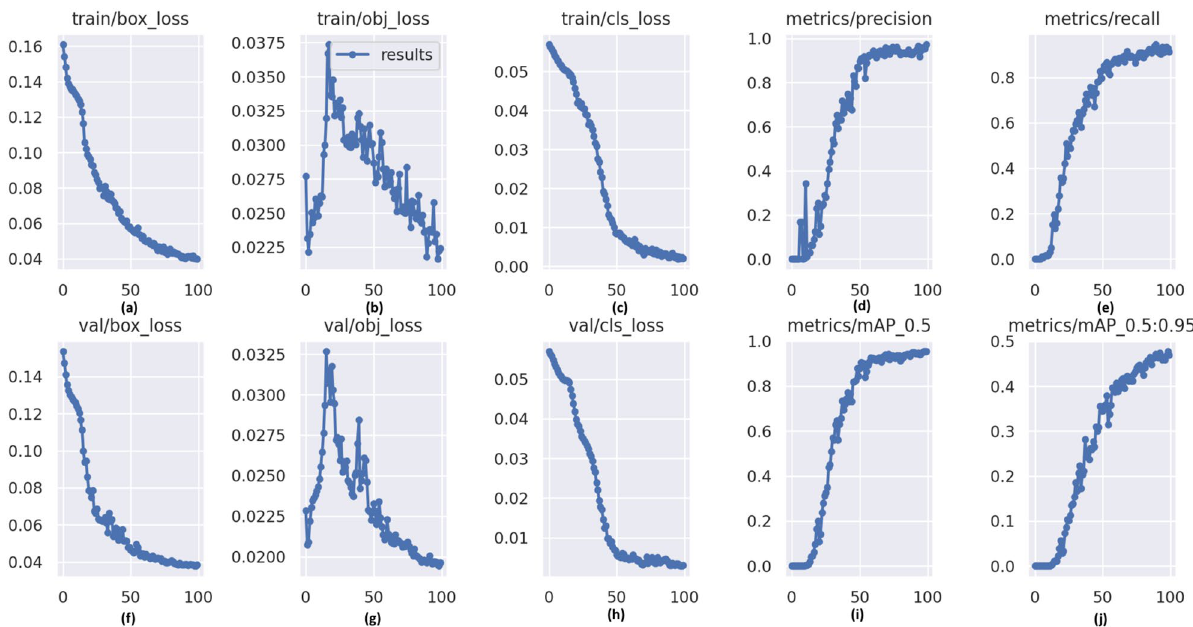
Figure 5. The training and validation curves for our model using low-resolution images. Plots ( a – c ) show the box loss, object loss and classification loss for the training sample. Figures ( f – h ) capture the same metrics for the validation dataset. The figures ( d ) and ( e ) show the precision and recall of the model. The figures ( i ) and ( j ) capture the mAP at IoU = 0.5 and IoU = 0.5:0.95 respectively. For each figure, the x-axis represents the number of epochs.